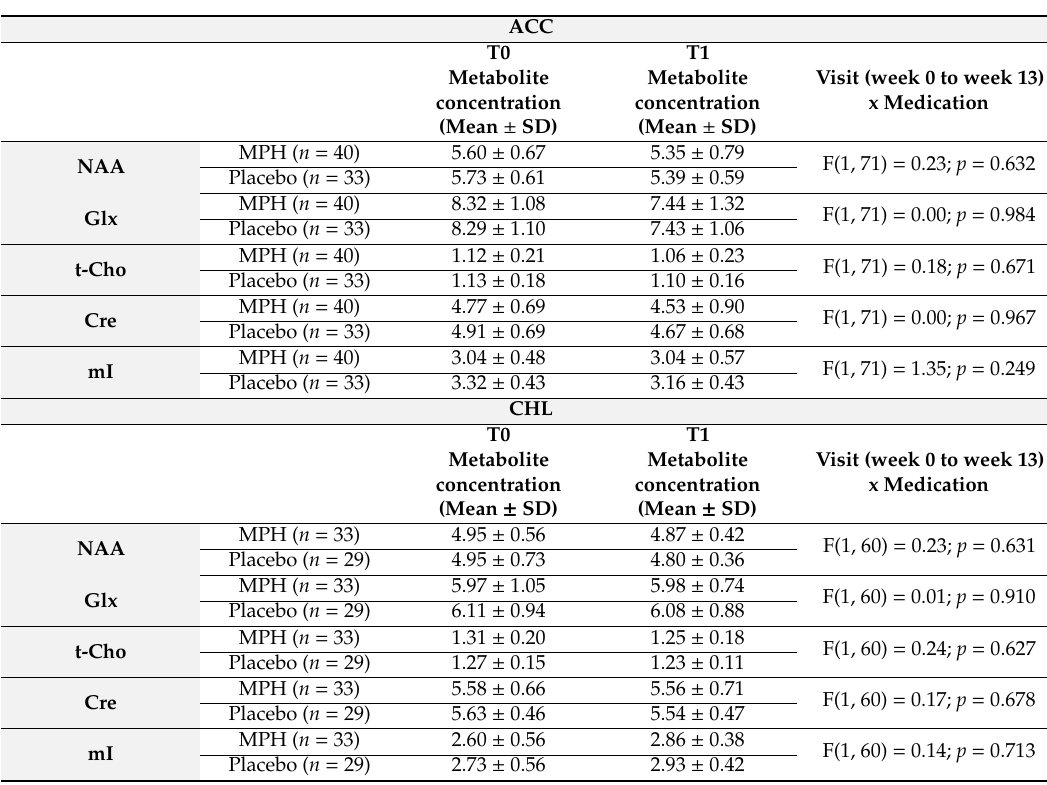
Table 3. The e ff ect of methylphenidate compared with placebo at baseline and 12 weeks after therapy